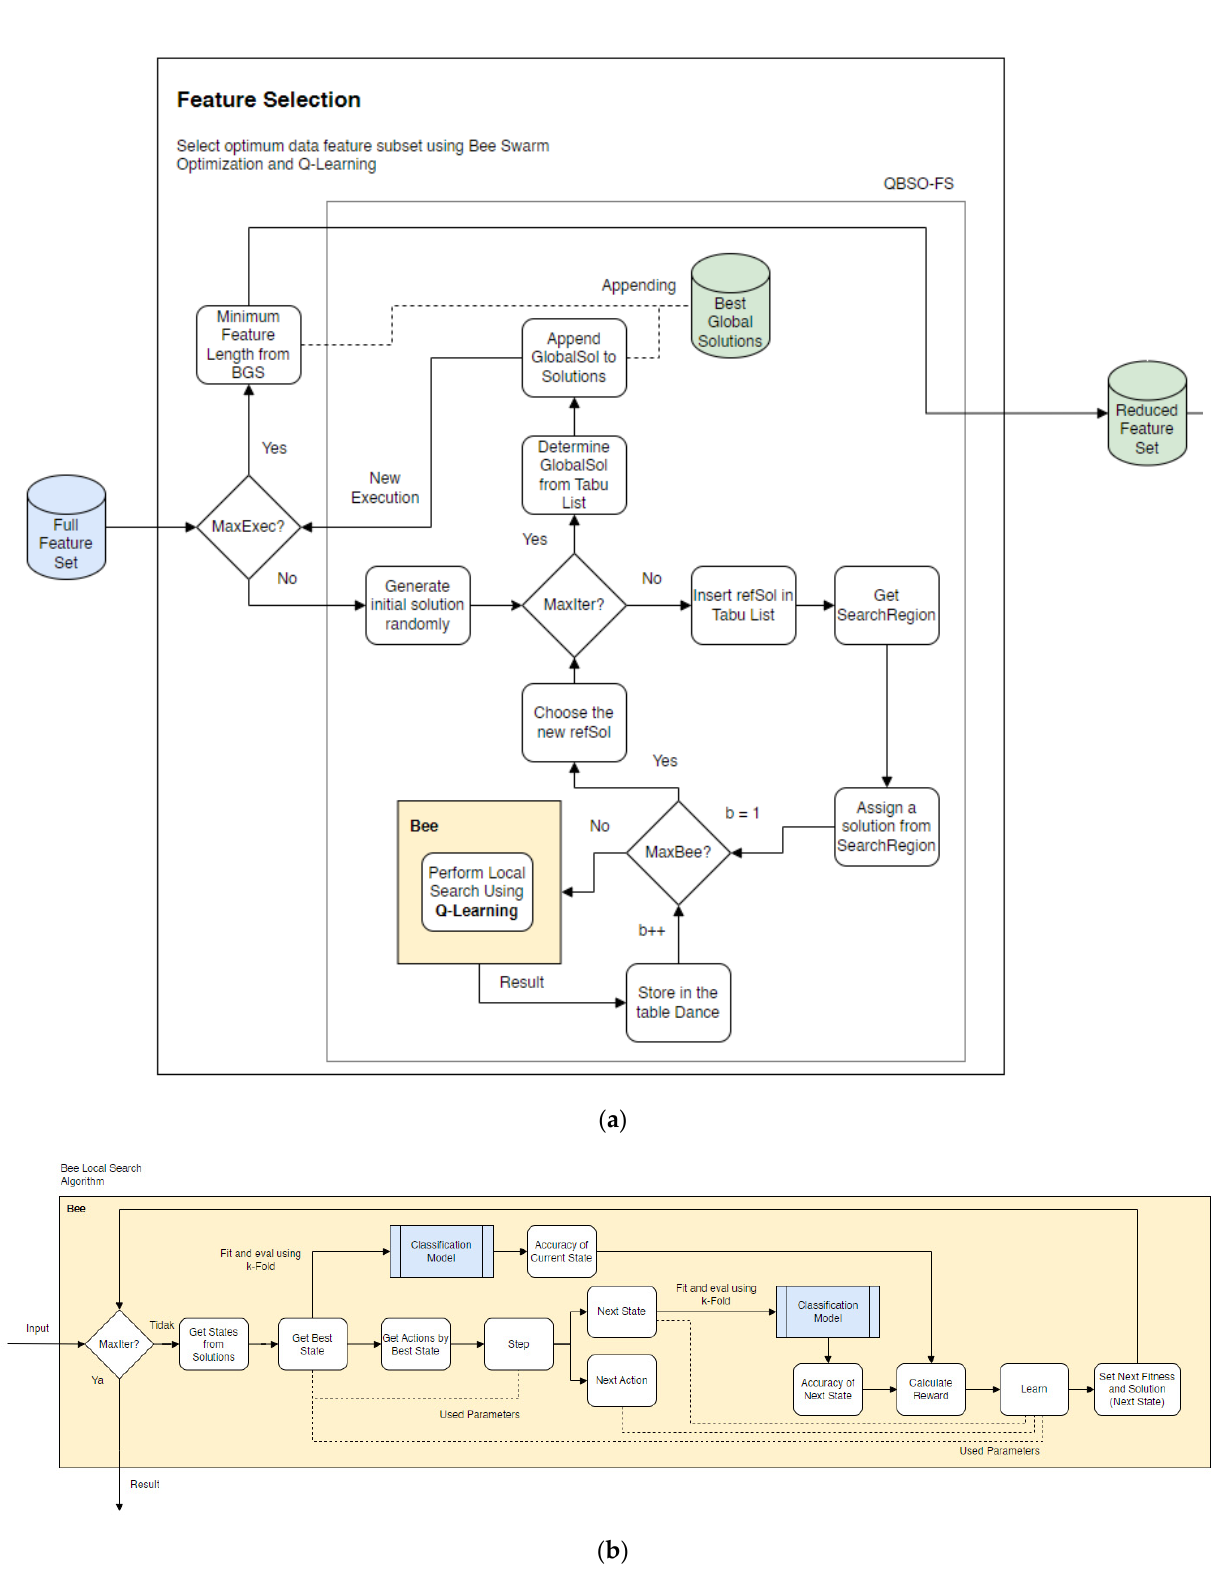
Figure 1. A flowchart of the proposed QBSO-FS models. ( a ) the bee swarm optimization approach; ( b ) the Q-learning approach. ( b ) the Q-learning